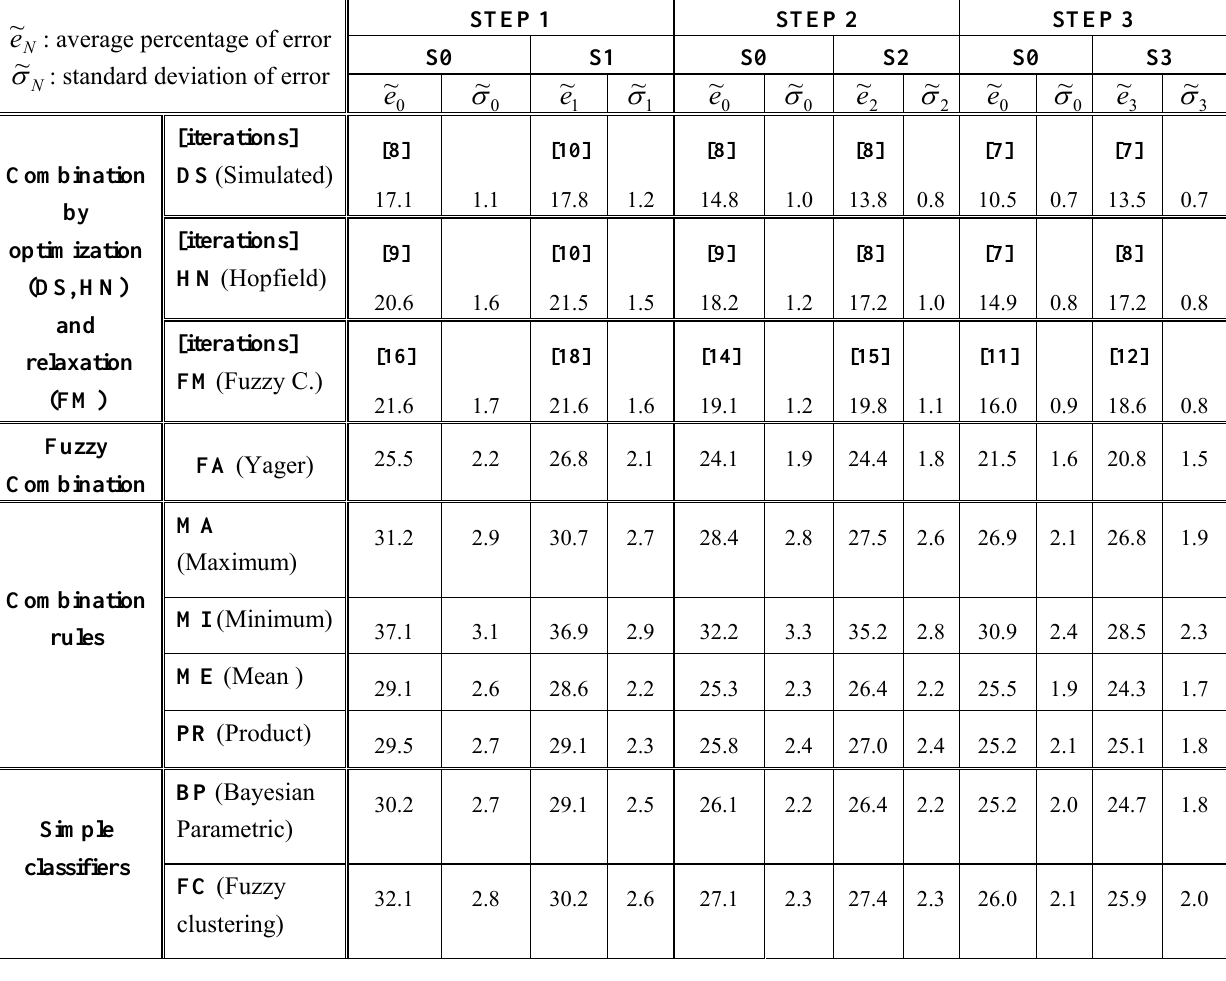
Table 2. Average percentages of error and standard deviations at each STEP for the four sets of tested images S0, S1, S2 and